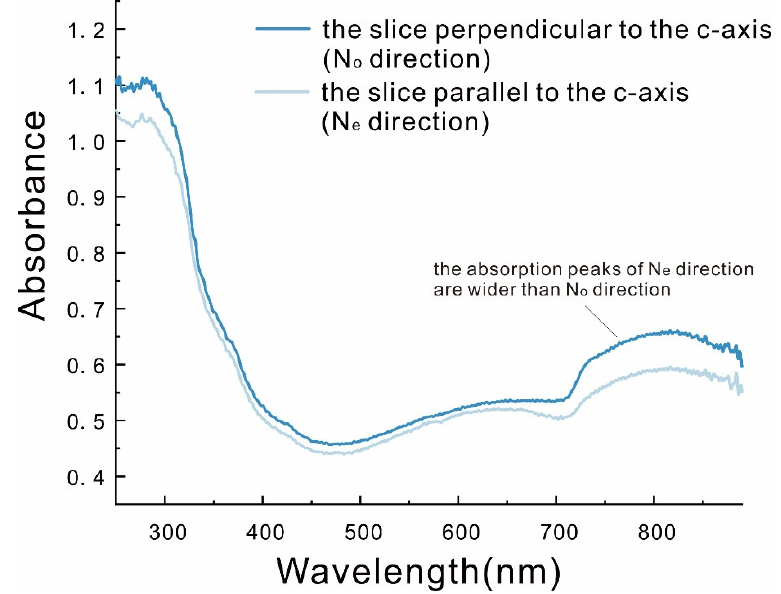
Figure 5. UV–Vis spectrum of A-1 slices parallel and vertical to the c -axis.